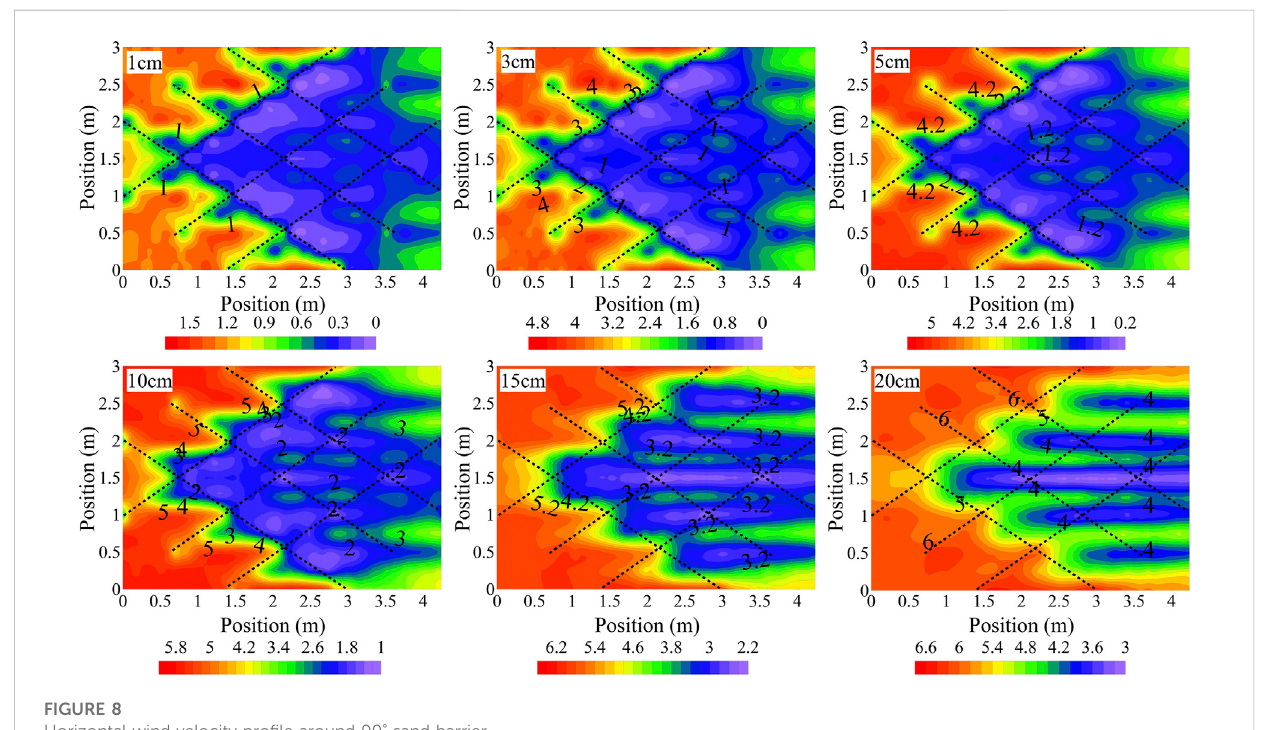
FIGURE 8 Horizontal wind velocity pro fi le around 90 ° sand barrier.